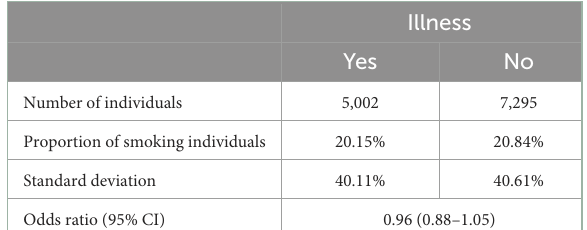
TABLE 2 Proportion of smoking individuals with respect to illness